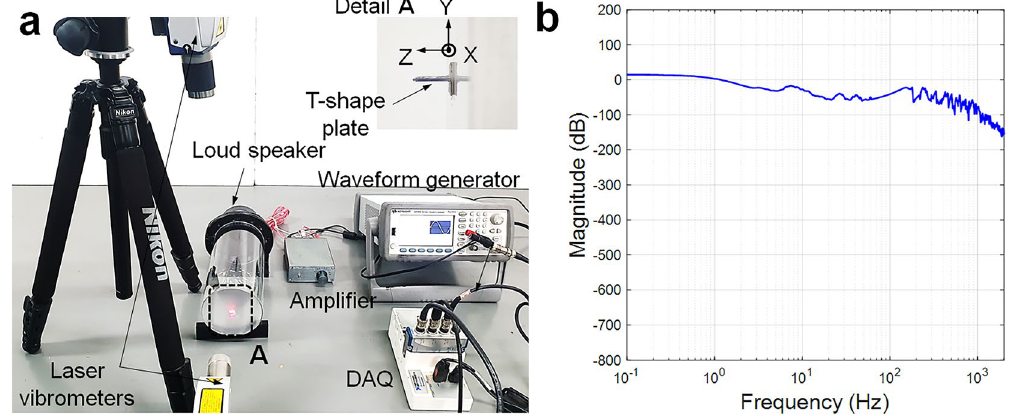
Figure 3. Vibration characteristics of viscoelastic acoustic diaphragm: ( a ) experimental setup, ( b ) its frequency response function (magnitude).